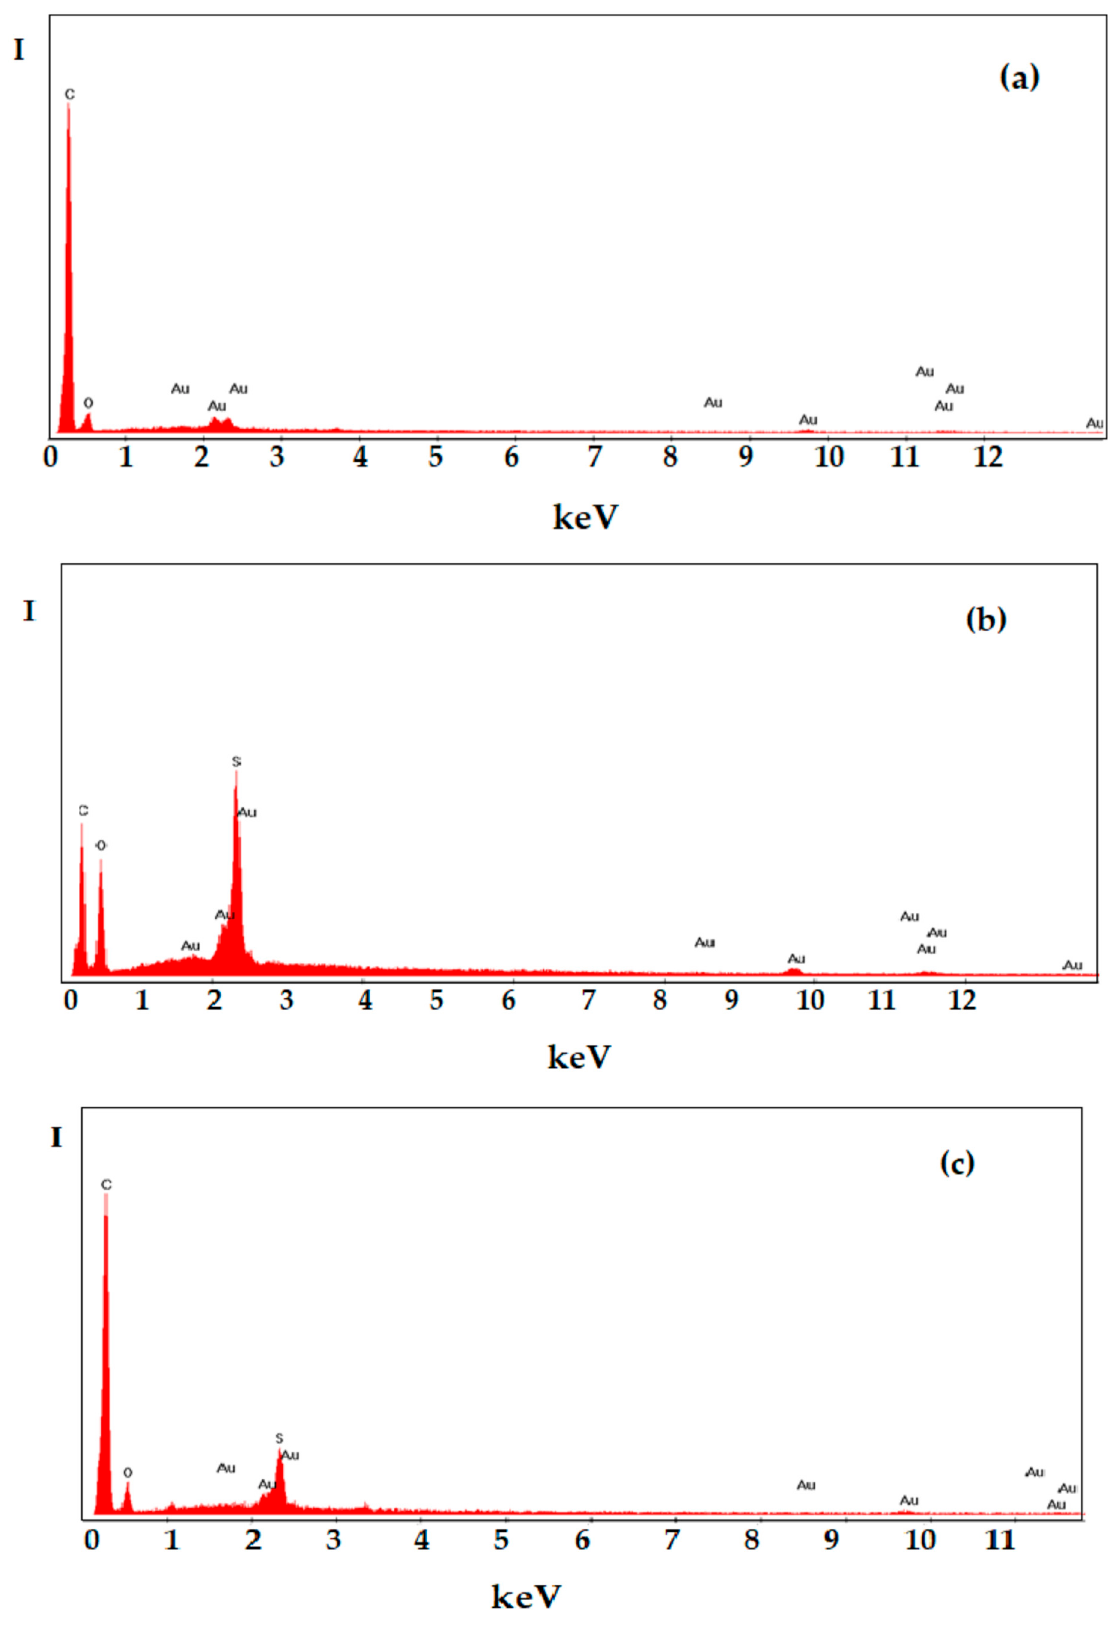
Figure 6. Energy dispersive X-ray analysis (EADX) on: ( a ) polypropylene hollow-fiber membrane (PPHF); ( b ) sulfonated polyether ether ketone (sPEEK)–polypropylene hollow fiber (sPEEK/PPHF); and ( c ) chitosan (Chi)–sulfonated poly (ether ether ketone) (sPEEK)–polypropylene hollow fiber